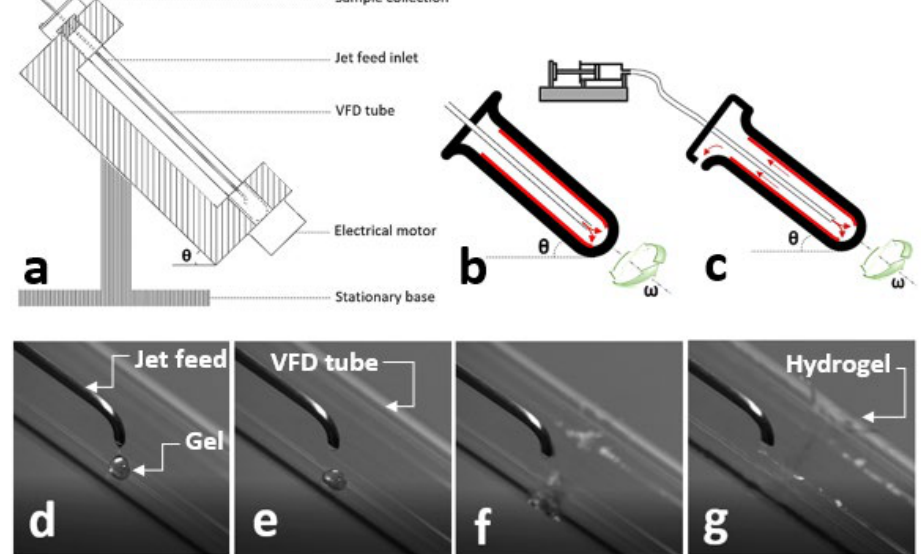
Figure 1. ( a ) Schematic drawing of a vortex fluidic device (VFD) indicating its